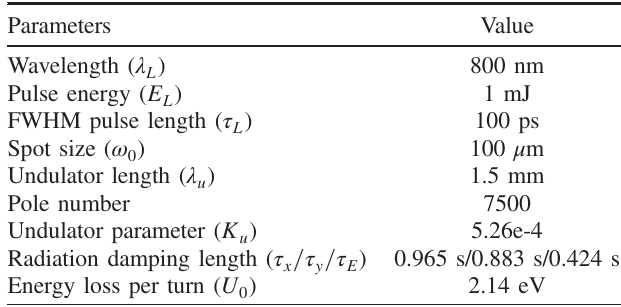
TABLE V. Laser cavity parameters and equivalent undulator parameters with modified damping